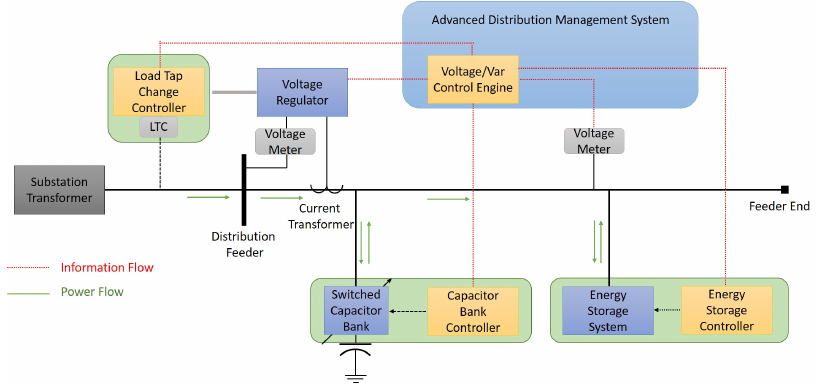
Figure 1. The voltage control scheme in the distribution system.